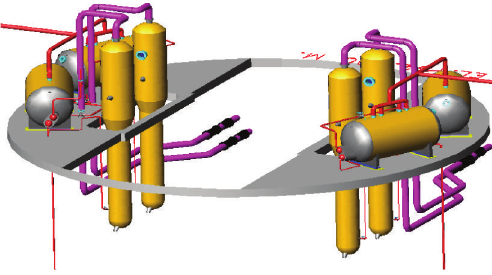
Figure 2: Layout for the four SGs and the